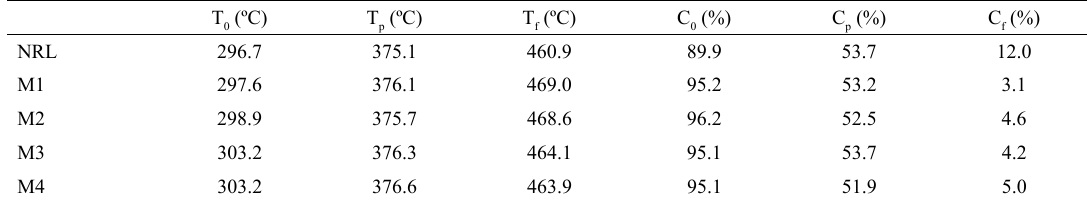
Table 2. Thermogravimetric data obtained from the treated membranes, where T the maximum temperature degradation, T in T , T , and T , respectively. 0 p f